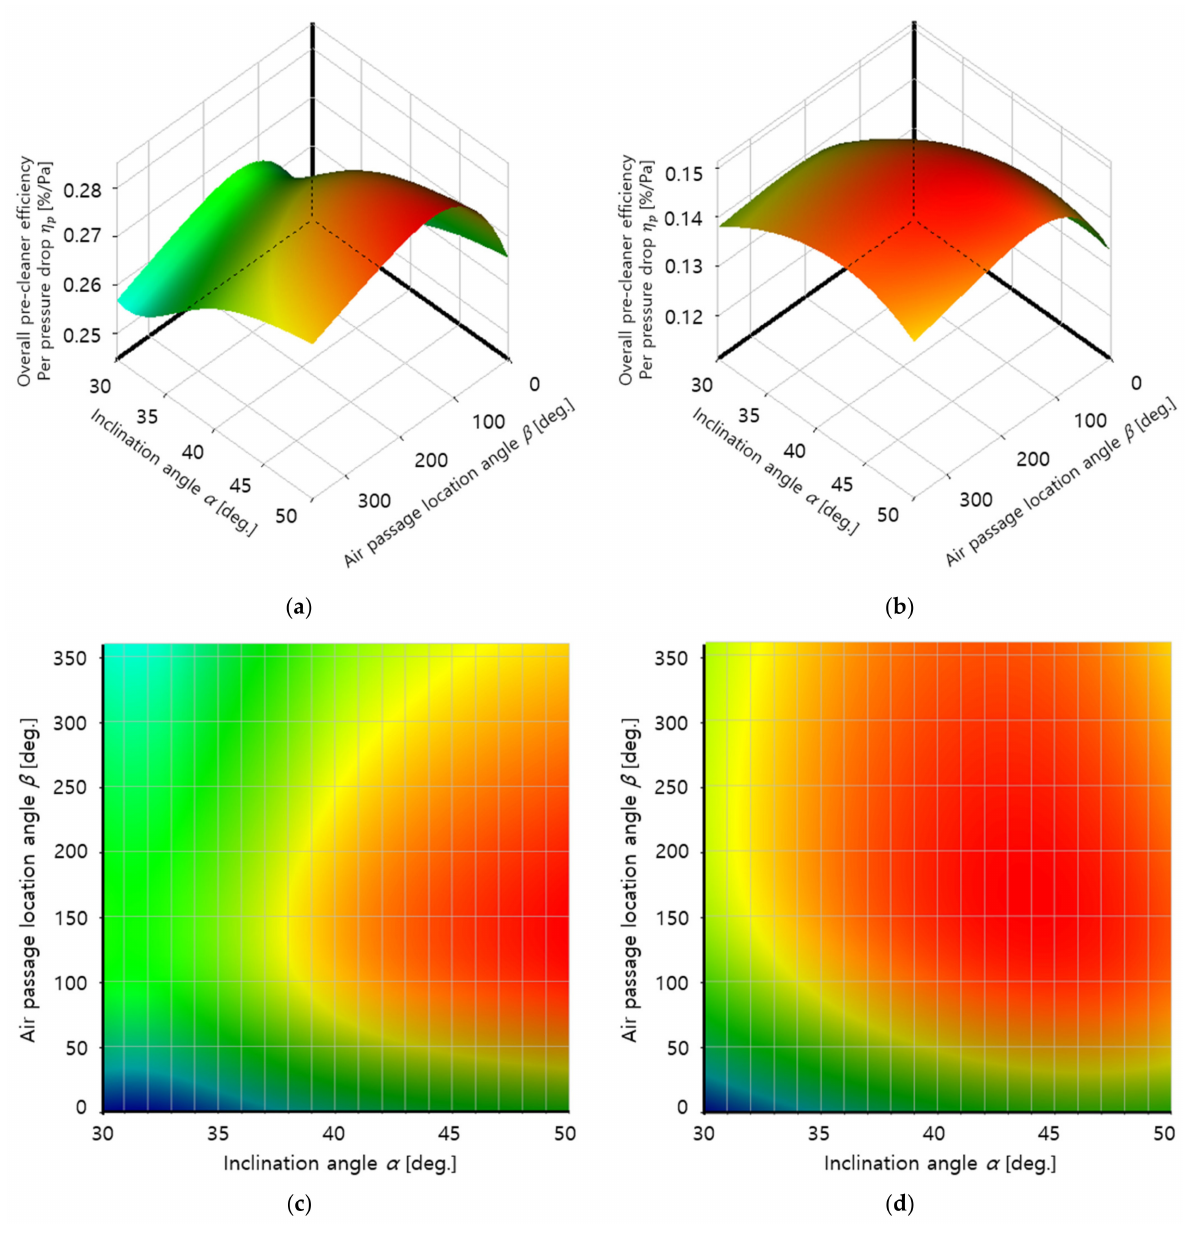
Figure 15. Overall pre-cleaner efficiency per pressure drop η p according to change in design variables α and β : response surfaces at ( a ) 4500 rpm and ( b ) 6000 rpm and response planes at ( c ) 4500 rpm and ( d ) 6000